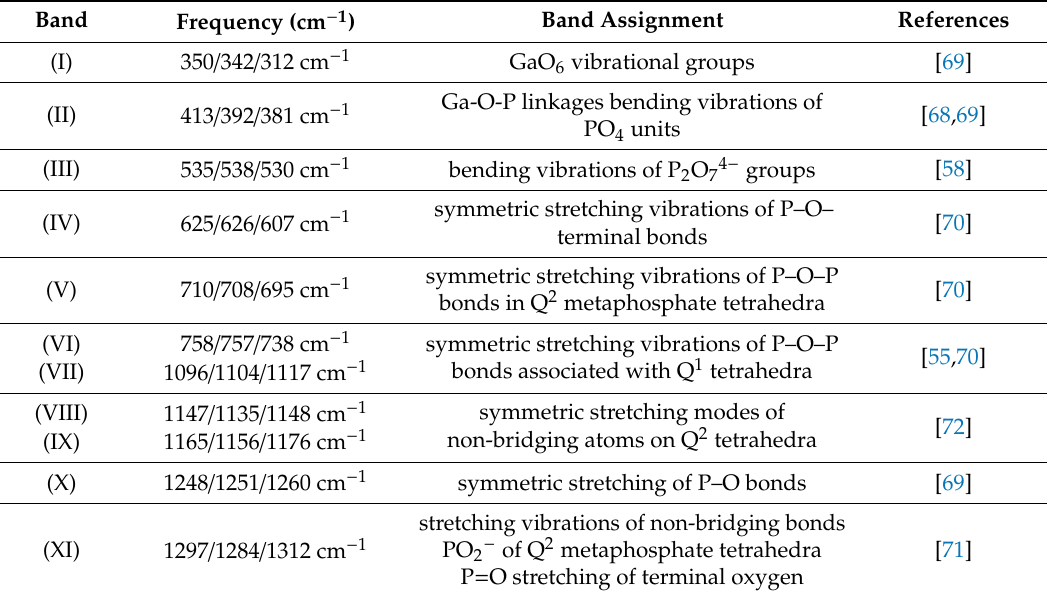
Table 2. Band positions and their assignments.